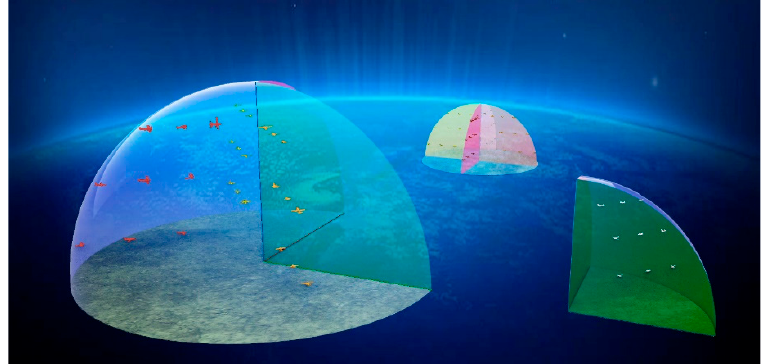
Figure 8. MR visual field scene schematic: where the left hemisphere is the range of the subject’s visual field; the right side is the range of a separate direction; the upper part is the schematic of the four directions in which the target is located.